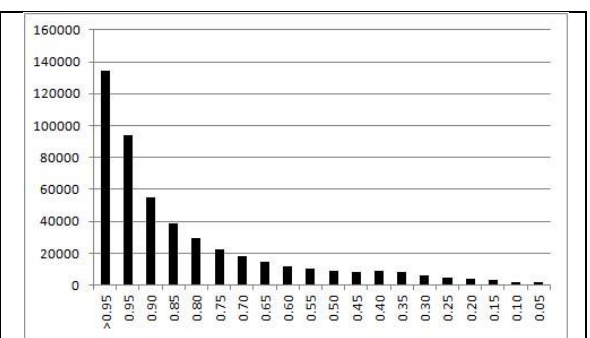
Fig. 6: frequency distribution of correlation coefficient (area of figure 8), horizontal: correlation coefficient, vertical: frequency